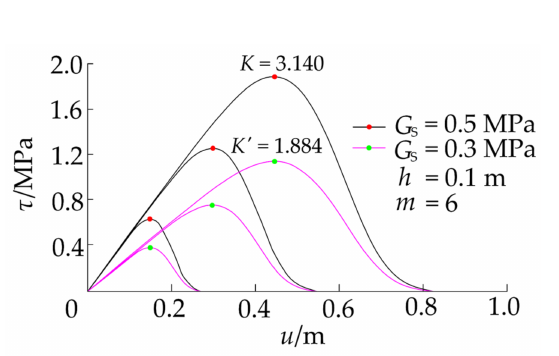
Figure 6. Envelope curves of equivalent